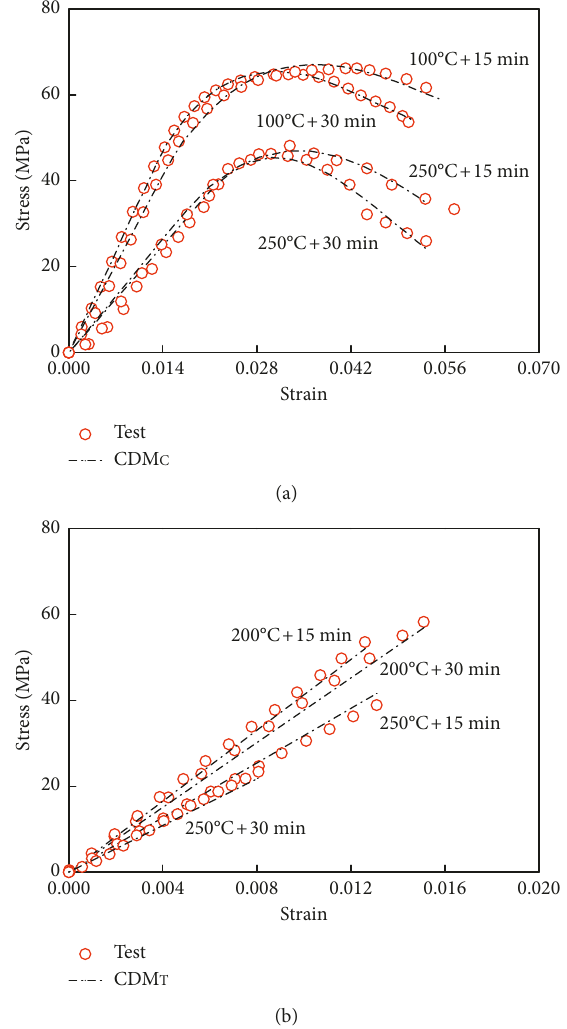
Figure 12: Stress-strain relationship of wood after high-exposure temperature when using natural cooling: (a) compressive condi- tion; (b) tensile